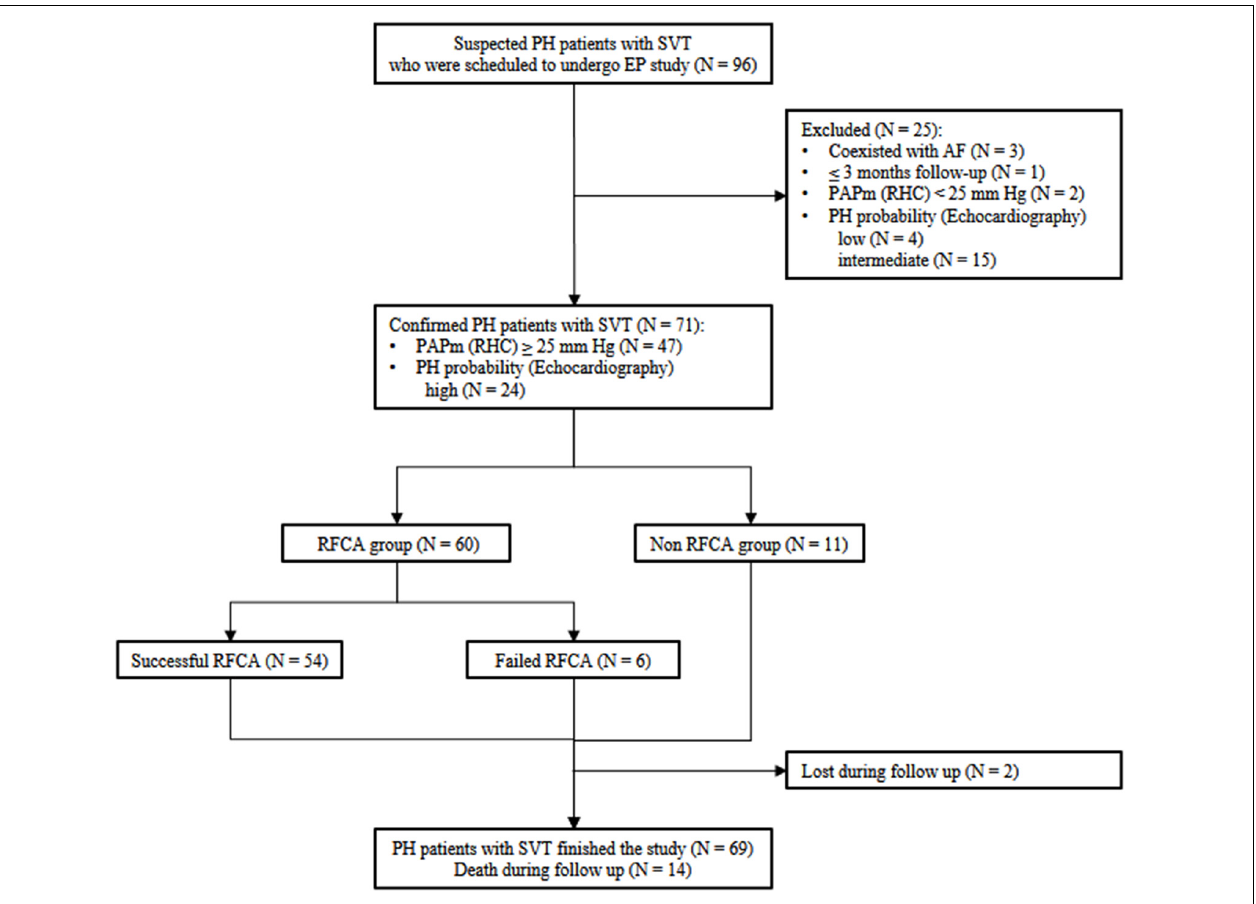
FIGURE 1 | Flow chart for the inclusion-exclusion of the study population. PH, pulmonary hypertension; SVT, supraventricular tachycardia; EP, electrophysiology; RFCA, radiofrequency catheter ablation; RHC, right heart